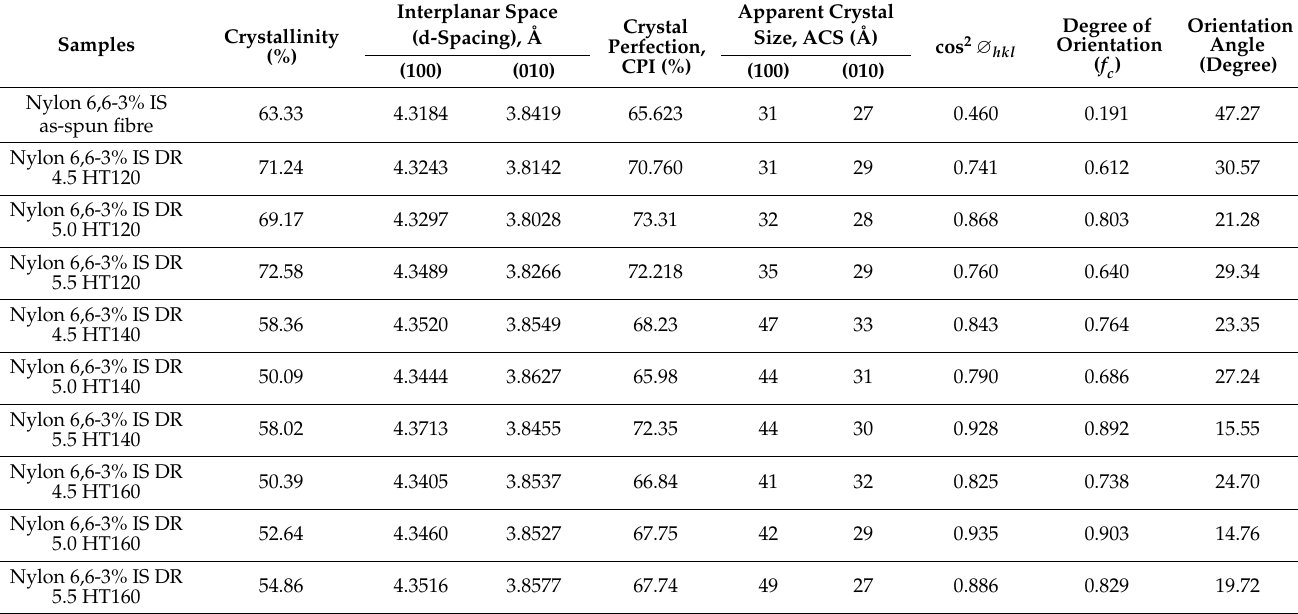
Table 2. Crystallographic properties of the as-spun and drawn salt-confined nylon 6,6 fibres.